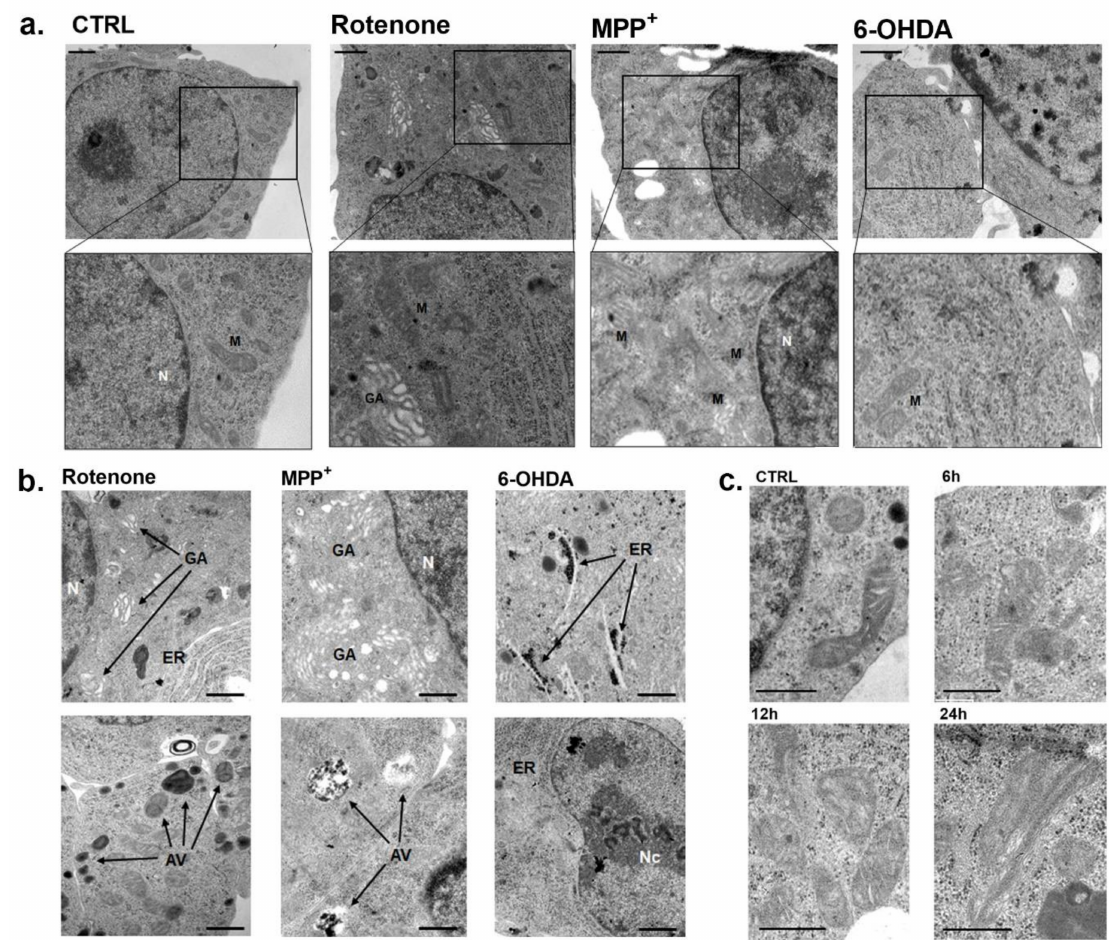
Figure 4. Electron micrographs of INS-1 β -cells exposed to rotenone, MPP + and 6-OHDA. ( a ) Ultrathin sections of INS-1 cells with enlarged zoom in of mitochondria after 6 h incubation with rotenone (15 nM), MPP + (80 µ M) and 6-OHDA (65 µ M), corresponding to the IC 50s of mitochondrial inhibition for each toxin. Scale bars correspond to 1 µ m. ( b ) Specific alterations observed after exposure to the IC 50s of mitochondrial inhibition for each toxin. Scale bars correspond to 1 µ m ( c ) Electron micrographs of progressive INS-1 mitochondrial alterations after exposure with rotenone 15 nM to increasing times (6, 12 and 24 h). All the figures are representative of three different experiments. Scale bars correspond to 500 nm. N: nucleus; Nc: nucleolus; M: mitochondria; GA: Golgi apparatus; ER: endoplasmic reticulum; AV: autophagic